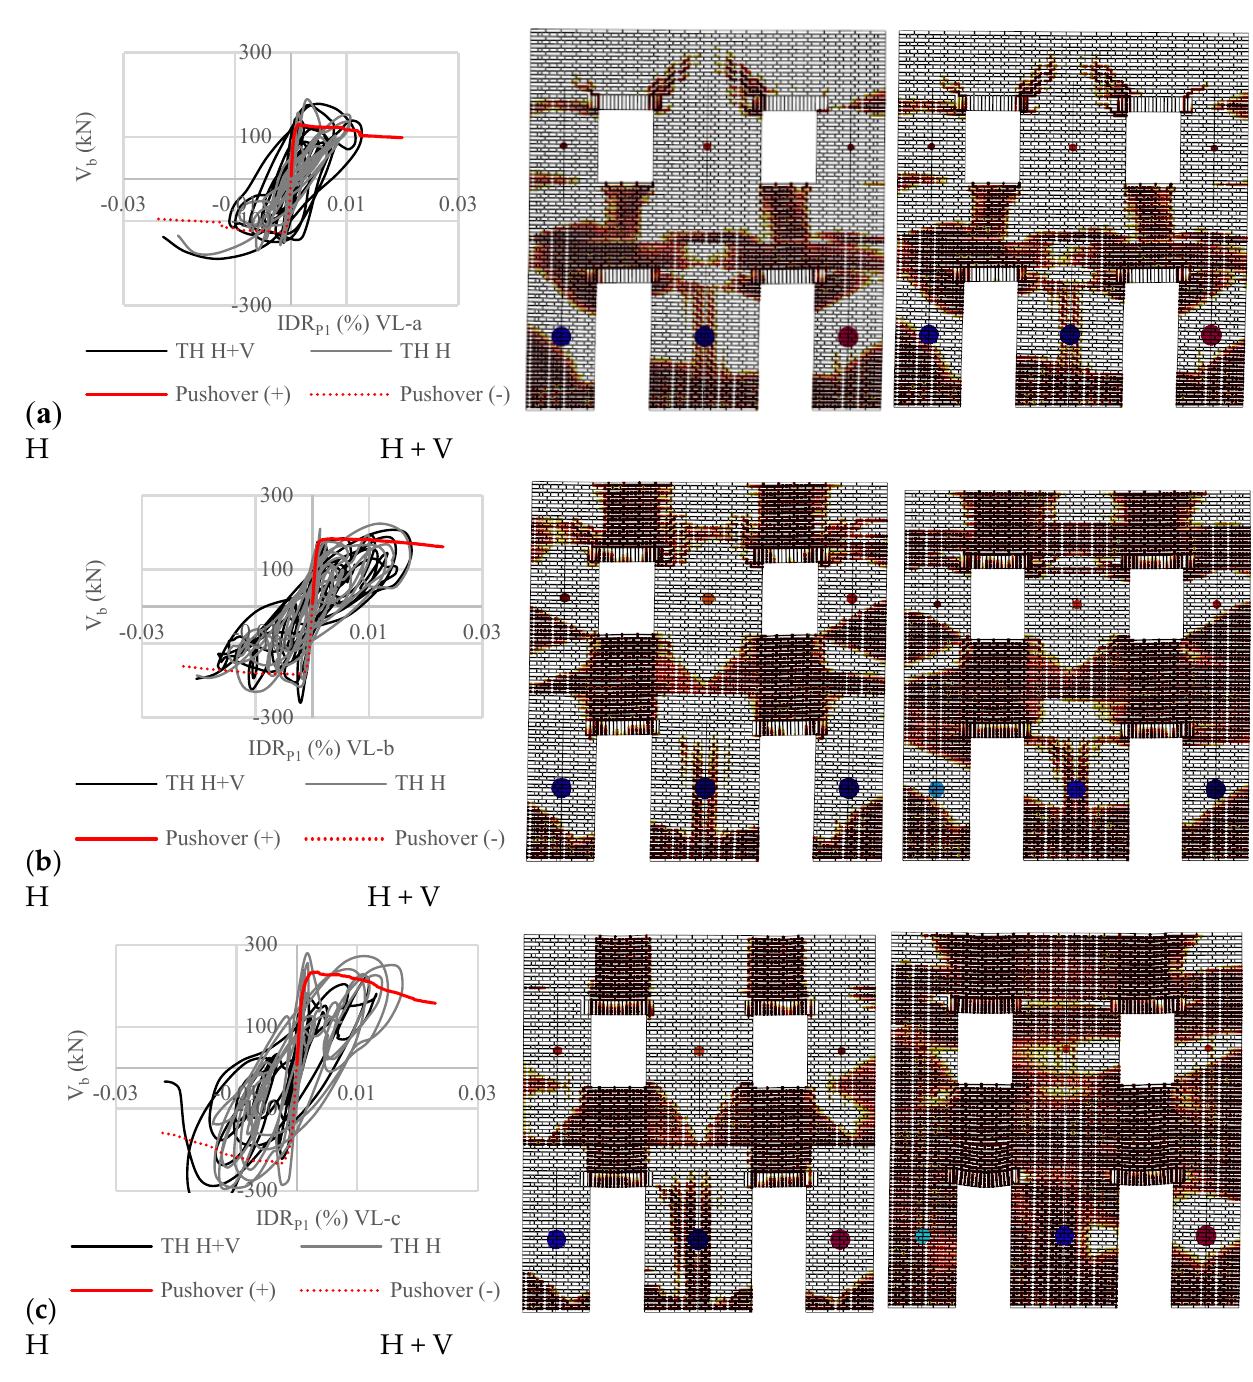
Figure 16. IDR- V b curves and crack patterns obtained for earthquake #2. TH results for the H component are in grey, TH results for H + V components are in black, the PO curve for positive displacements is the continuous red line, and the PO curve for negative displacements is the dashed red line. Loading conditions: VL-a ( a ), VL-b ( b ), and VL-c ( c ).